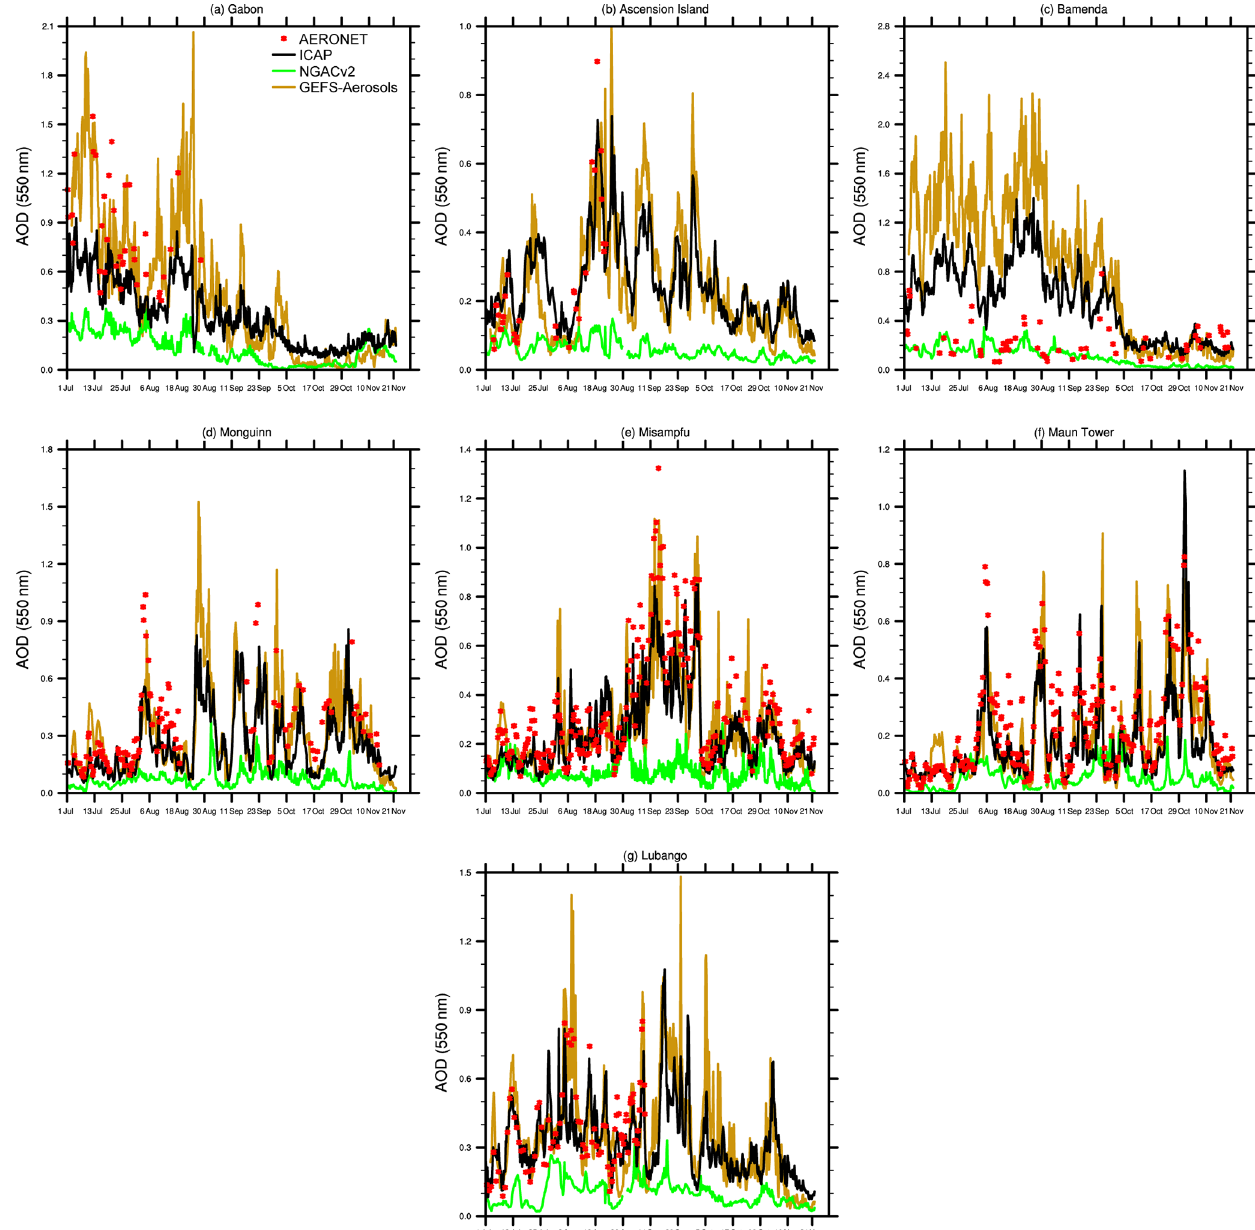
Figure 10. Day-1 AOD forecasts of GEFS-Aerosols, ICAP, and NGACv2 verified against AERONET sites in Africa during 5 July–30 November